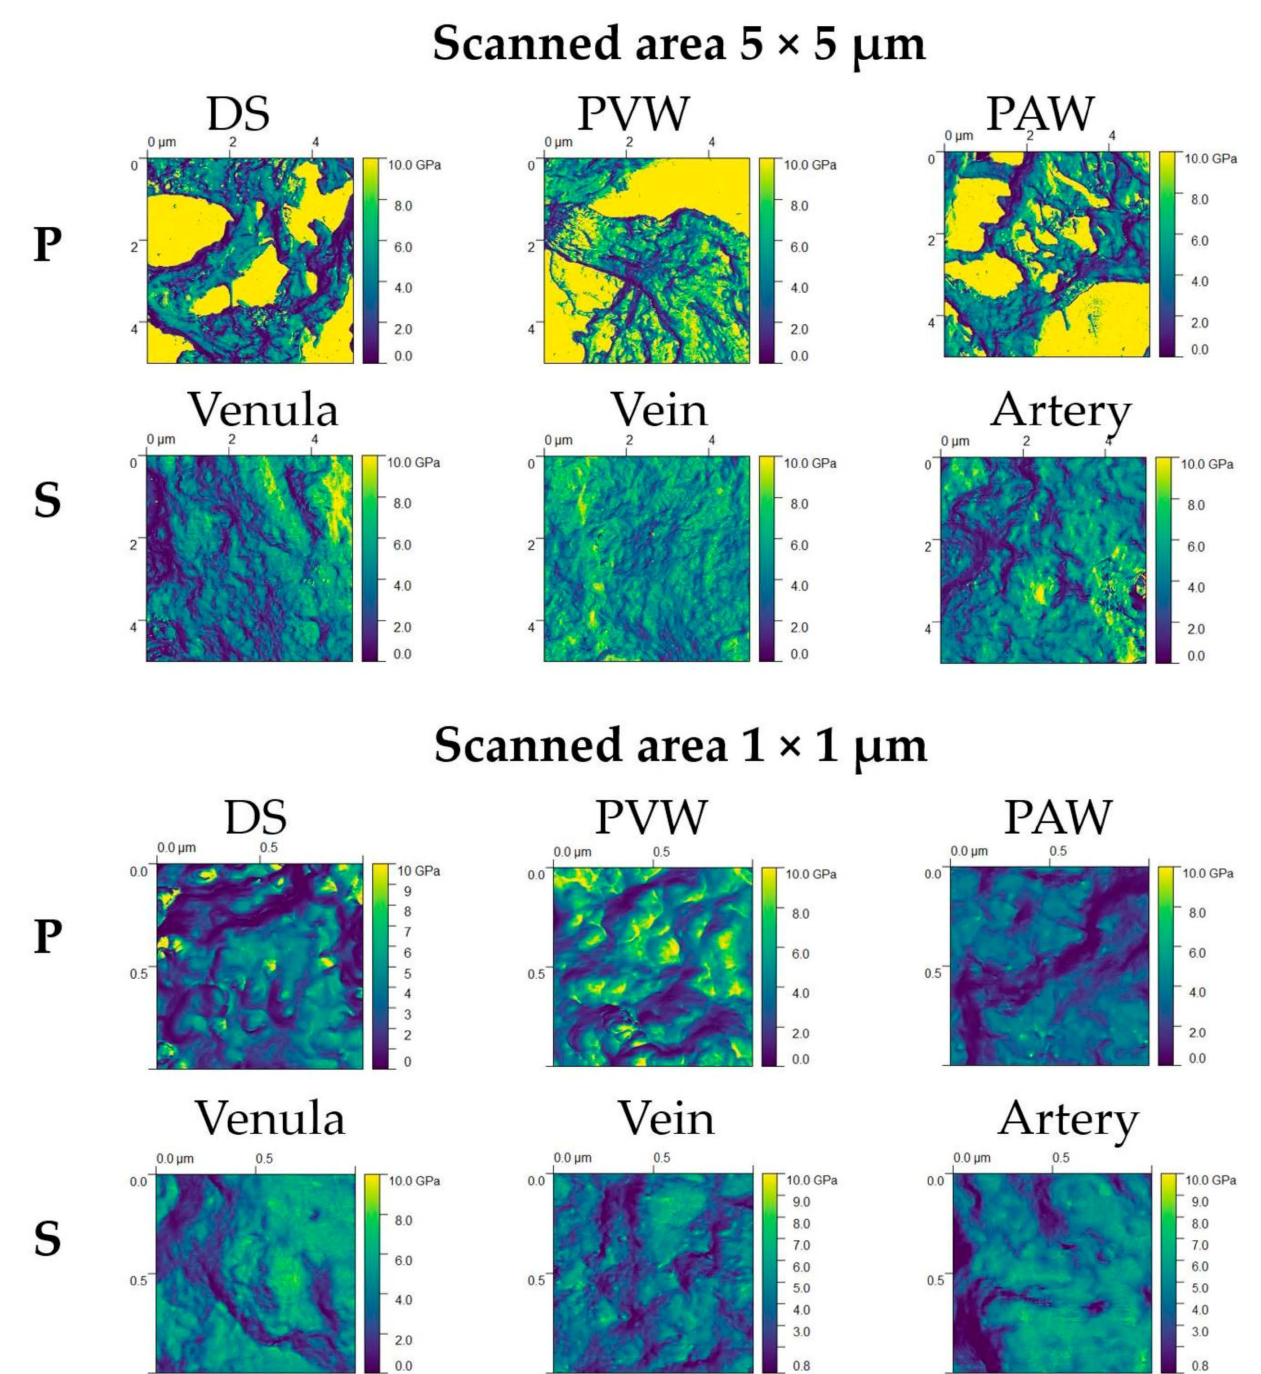
Figure A7. Stiffness mapping (normalized) of the different histoanatomical elements of the dehydrated parenchymal (P) and stromal (S) compartments of the LS-ECM in CE liver AOSSs measured on 5 × 5 and 1 × 1 µ m AFM scans. Yellow tone codes higher stiffness values, deep blue tone codes the minimal stiffness (up to 2 GPa), and green tone codes stiffness in the range of 2–8 GPa. Note that the areas colored in yellow in the 5 × 5 µ m scans of the parenchymal elements correspond to the areas without tissue (microscopy glass surface). The loose nature of the parenchymal ECM allows exposure of the glass surface, but results in very high variation of the stiffness values at the micron scale and masks any potential quantitative differences between the histoanatomical structures and compartments. The measurements on the 1 × 1 µ m scans vary much less. Abbreviations: DS—Disse’s space; PVW—parenchymal ECM near vein wall; and PAW—parenchymal ECM near artery